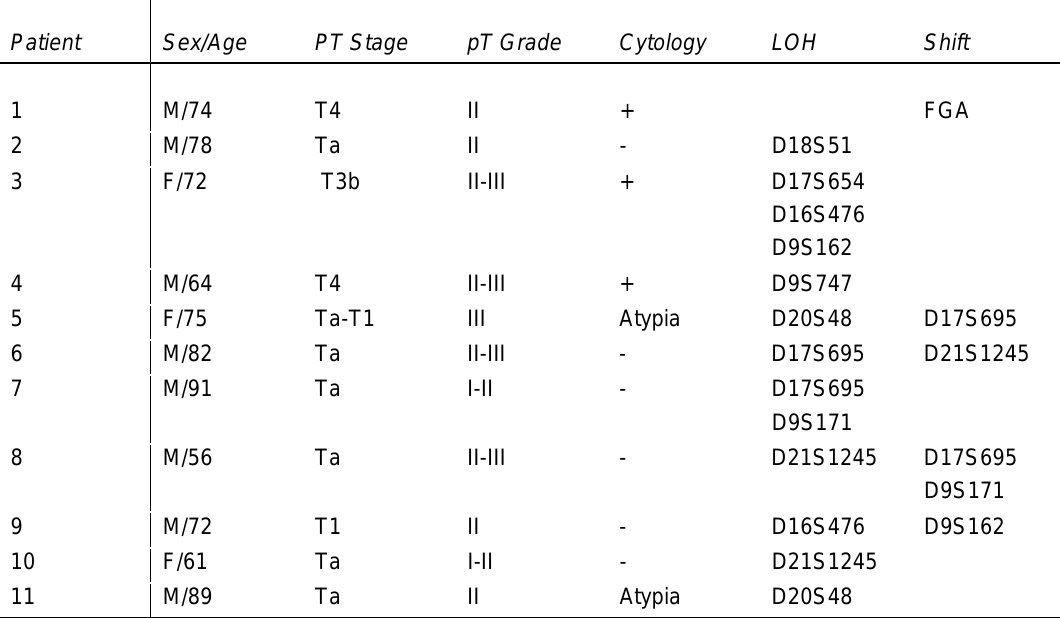
Clinicopathological and Genetic